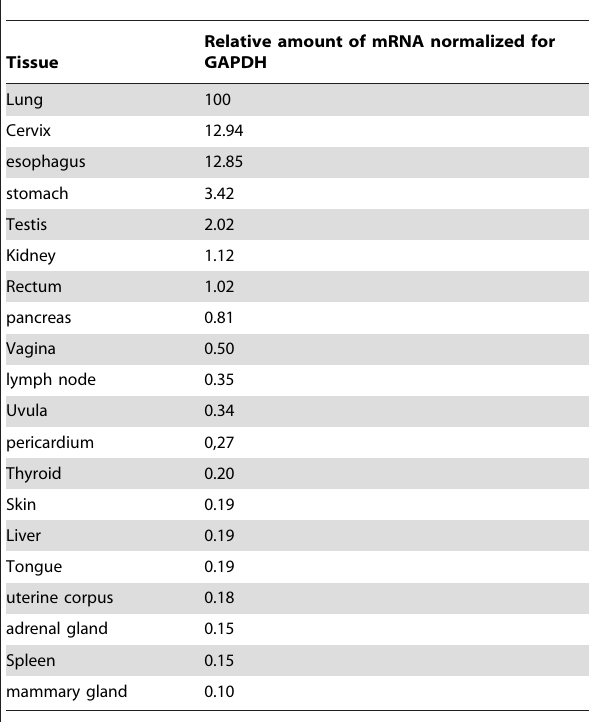
Table 1. Relative SFTA2 mRNA levels in human tissues normalized to